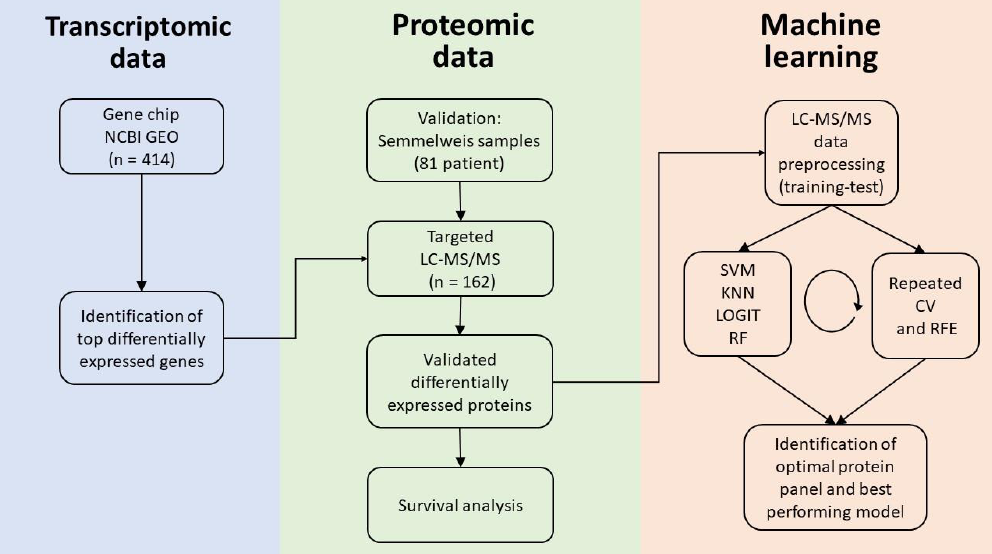
Figure 1. Analysis pipeline. Using gene chip data, we identified the top differentially expressed genes discriminating normal kidney tissue and ccRCC. We verified the identified gene panel using an independent validation cohort. We performed targeted LC-MS/MS to measure protein abundance for the selected top genes in the Semmelweis cohort. Using proteomic data, we established an optimal gene panel and the most accurate model for ccRCC detection. CV: K-fold cross-validation, RFE: recursive feature elimination, KNN: k-nearest neighbors, RF: random forest, LOGIT: logistic regression, and SVM: support vector machines